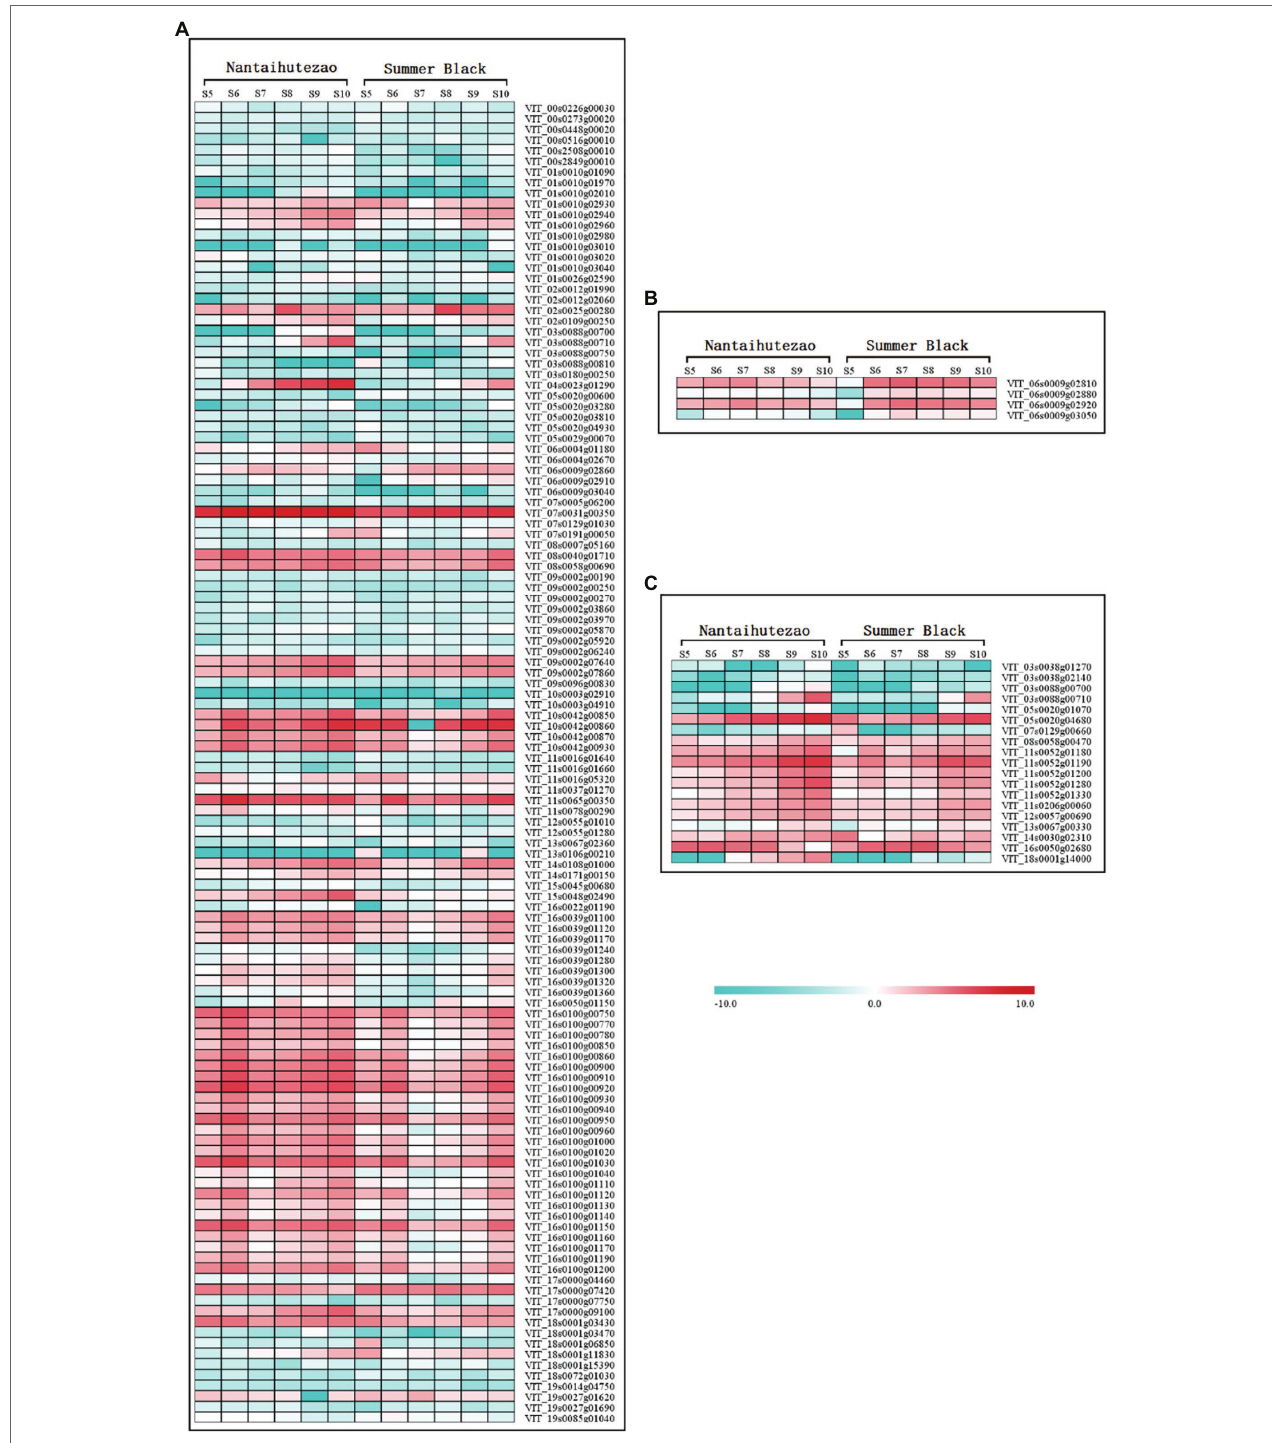
FIGURE 7 | The expression profiles of genes enriched in the different Kyoto Encyclopedia of Genes and Genomes (KEGG) pathways in the modules correlated with the contents of resveratrol. Boxes from left to right that follow the berry development were obtained by using the MultiExperiment Viewer software. The data set was normalized to the values as log 2 transformed. The left set of boxes is for the bud sport ‘Nantaihutezao’, and the right set is for ‘Summer Black’. (A) Genes negatively correlated with the contents of trans -resveratrol; (B) genes positively correlated with the contents of trans -resveratrol; and (C) genes negatively correlated with the contents of cis